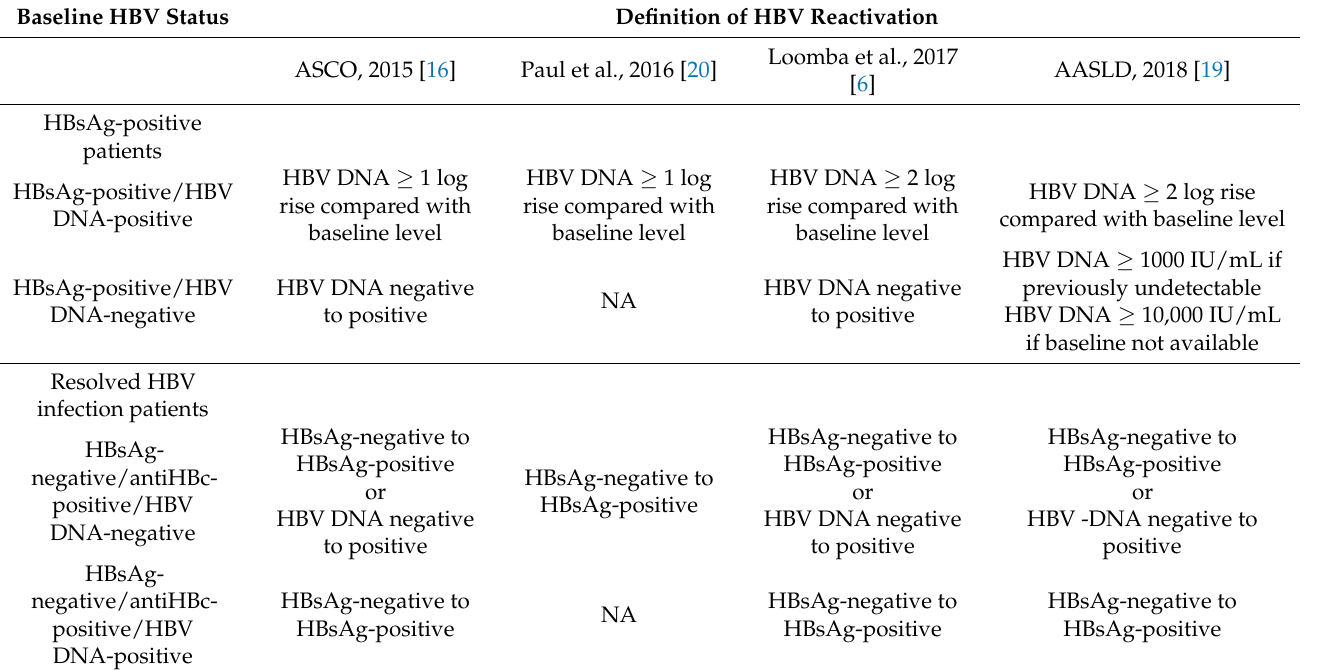
Table 1. Diagnostic criteria for HBV